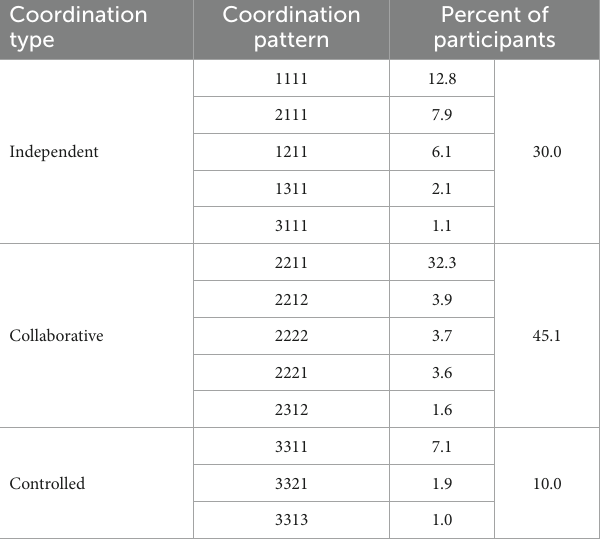
TABLE 3 Coordination types and corresponding coordination patterns for respondents included in study analyses. Coordination